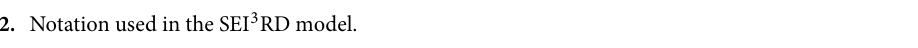
Table 2. Notation used in the SEI